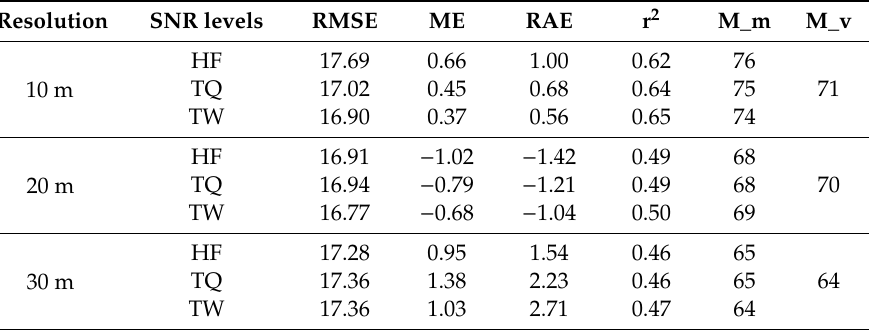
Table 4. Statistical metrics including RMSE, ME, and RAE in percentages in San Francisco. Correlations between validation data and model estimates, median values in percentage of model estimate (M_m), and validation